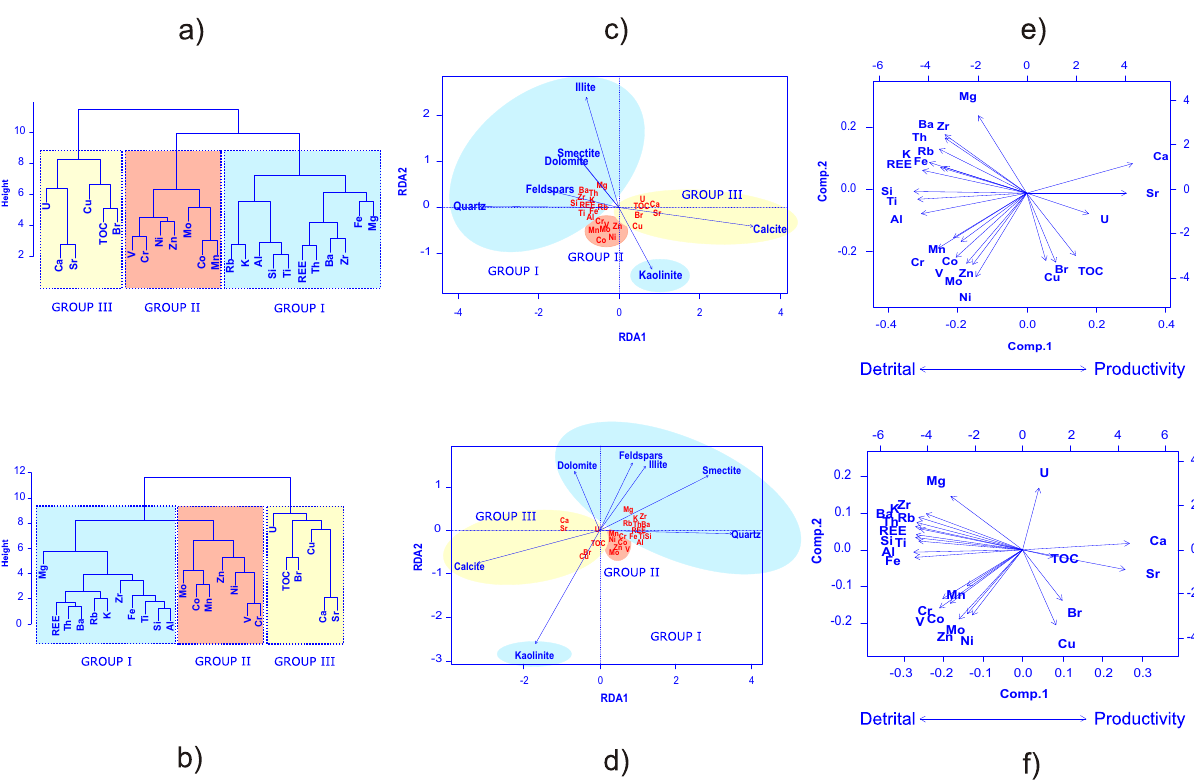
Fig. 3. Statistical treatment of data from both sites. Cluster analyses of the geochemical data for sites 305G (a) and 306G (b) , showing three main geochemical families in accordance to their affinity and origin. RDA biplots displaying the relationship between chemical elements and associated mineral phases for sites 305G (c) and 306G (d) . Light yellow, orange and blue areas indicate Group I, II and III, respectively. Biplots showing the first and the second eigenvector defined by PCA for sites 305G (e) and 306G (f)